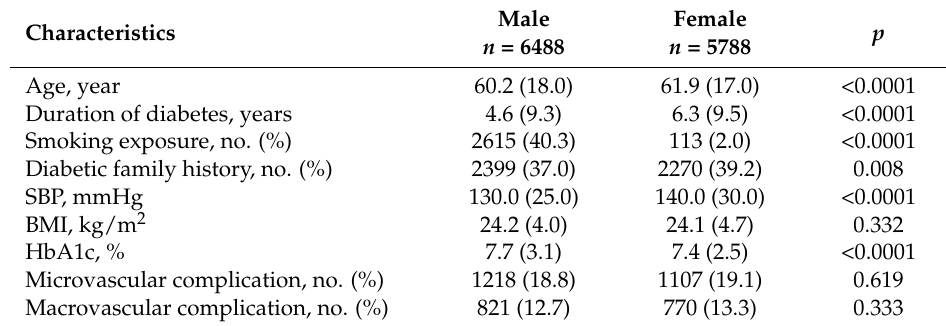
Table 1. Comparison of characteristics at baseline between male and female